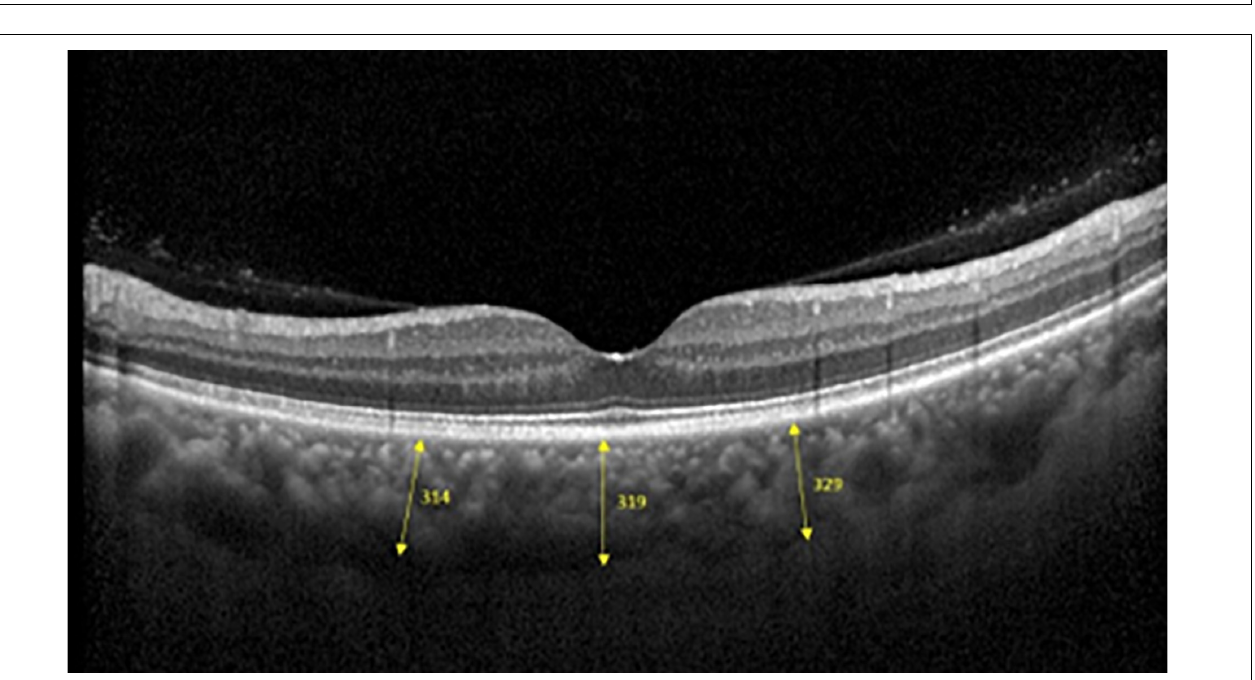
FIGURE 2 | Three positions at which choroid thicknesses was indicated in OCT